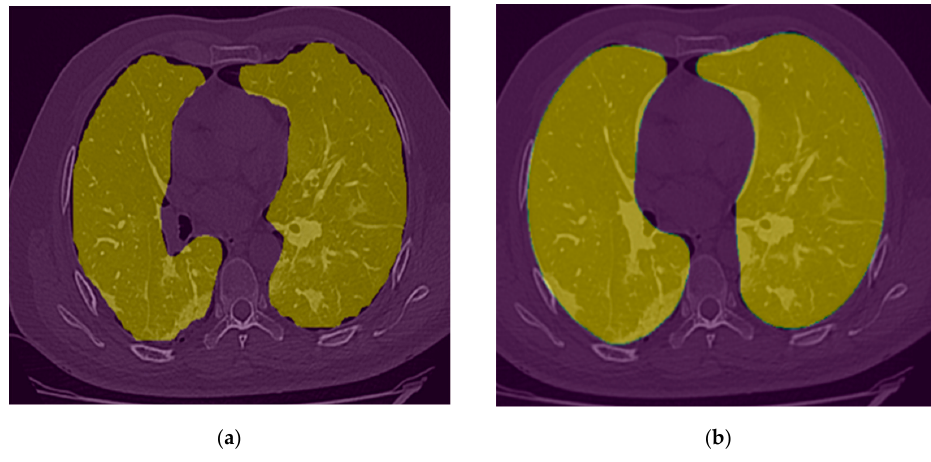
Figure 6. ( a ) Lung segmentation mask; ( b ) Post-processing lung segmentation.